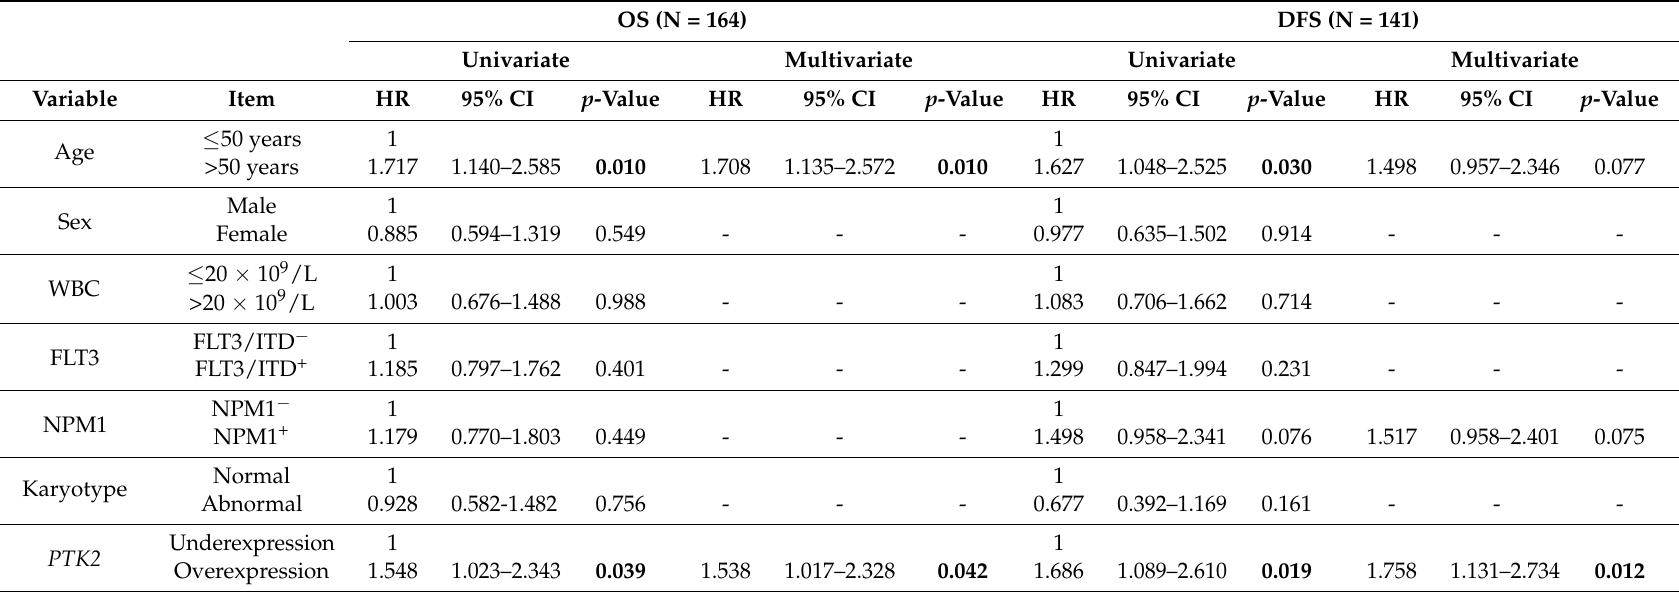
Table 6. Univariate and multivariate analyses of the association between relevant clinical variables and PTK2 expression with OS and DFS in patients with cytogenetic IR-AML and non-favorable FLT3/NPM1 combinations that underexpress PTK2B. OS (N = 164)